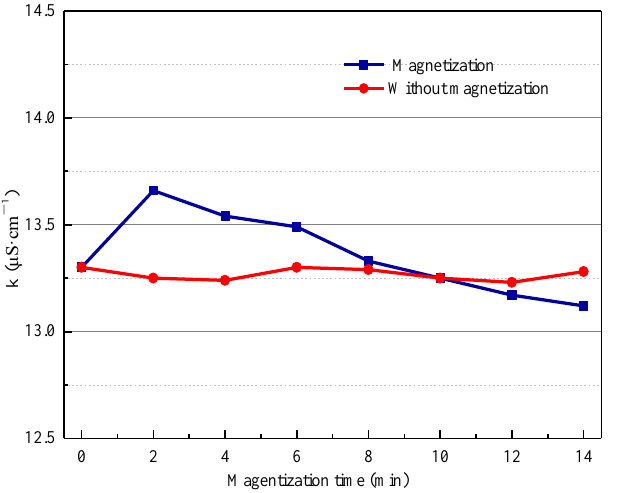
Figure 11. The relationship between conductivity and magnetization time.